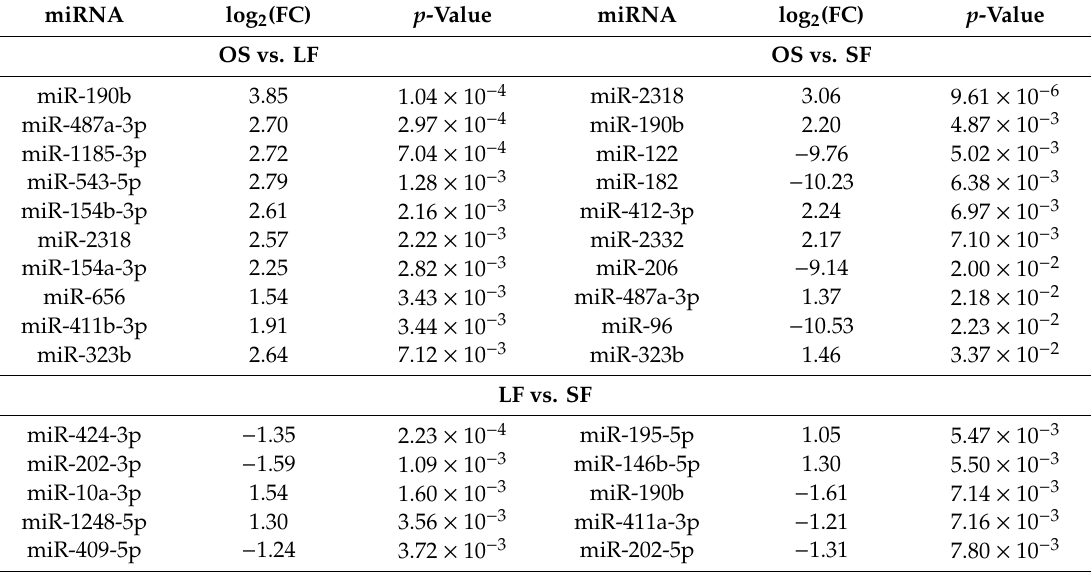
Table 2. Top 10 DEmiRNAs with a significant di ff